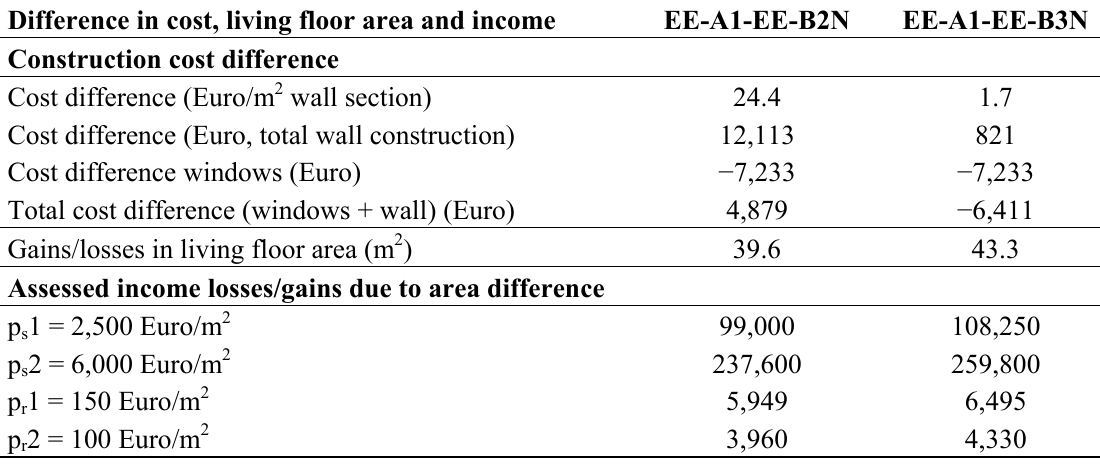
Table A5. Cost difference and assessed living area lost between energy-efficient and energy-efficient building constructed with new product, brick